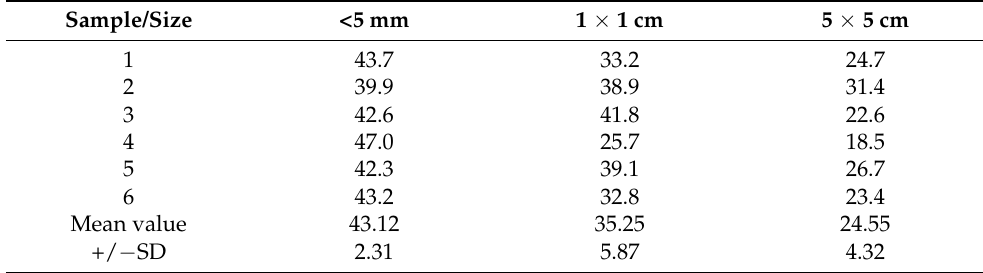
Table 3. Adhered material removal (%) by mechanical action during the crushing of dry nets.